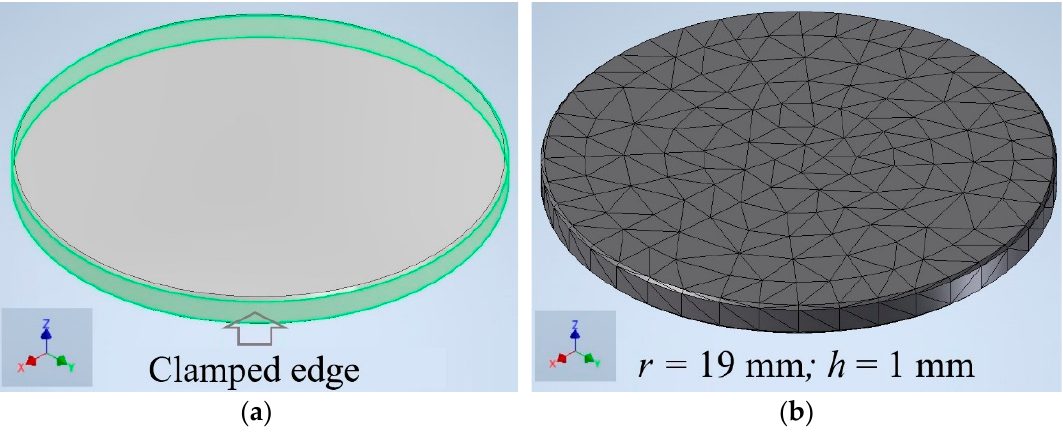
Figure 2. Aluminum membrane: finite element model ( a ) and numerical mesh ( b ).